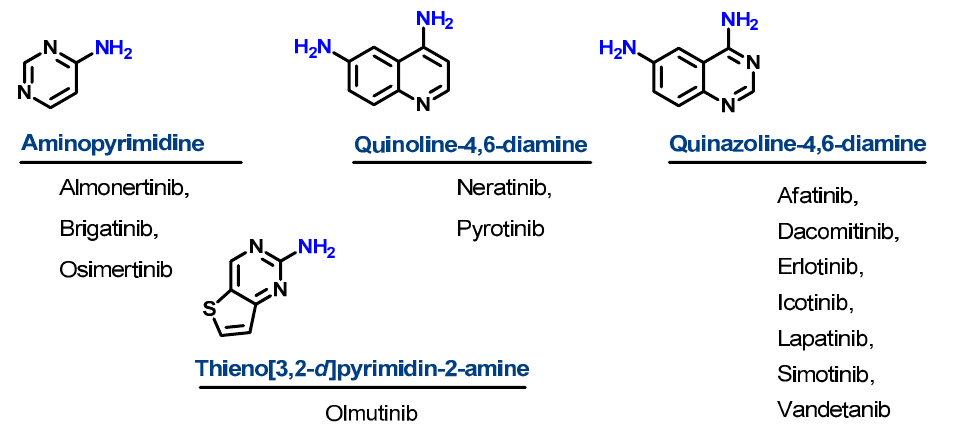
Figure 4. Chemical classification of EGFR-TKIs.